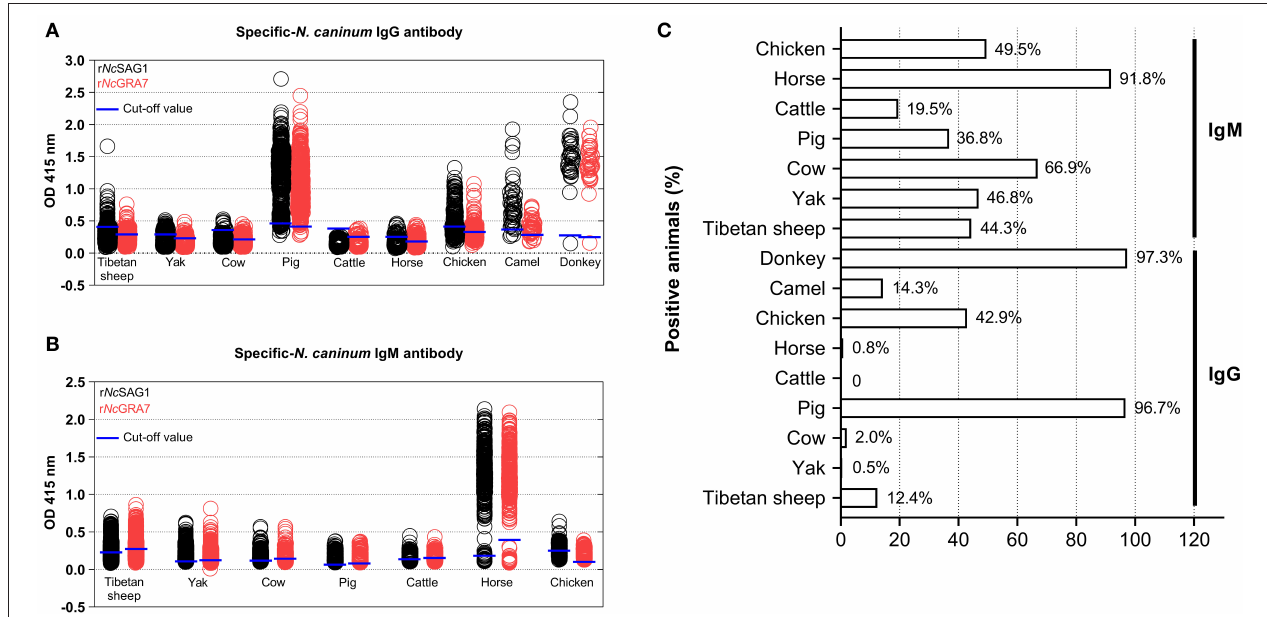
FIGURE 1 | Neospora caninum- specific IgG and IgM antibodies in various animals in the Qinghai-Tibet Plateau Area were detected by indirect ELISA methods based on the Nc SAG1 and Nc GRA7 antigens in this study. The blue short lines represented the cut-off values. (A) N. caninum -specific-IgG antibodies, (B) N. caninum -specific IgM antibodies, and (C) positive animals for neosporosis (%).